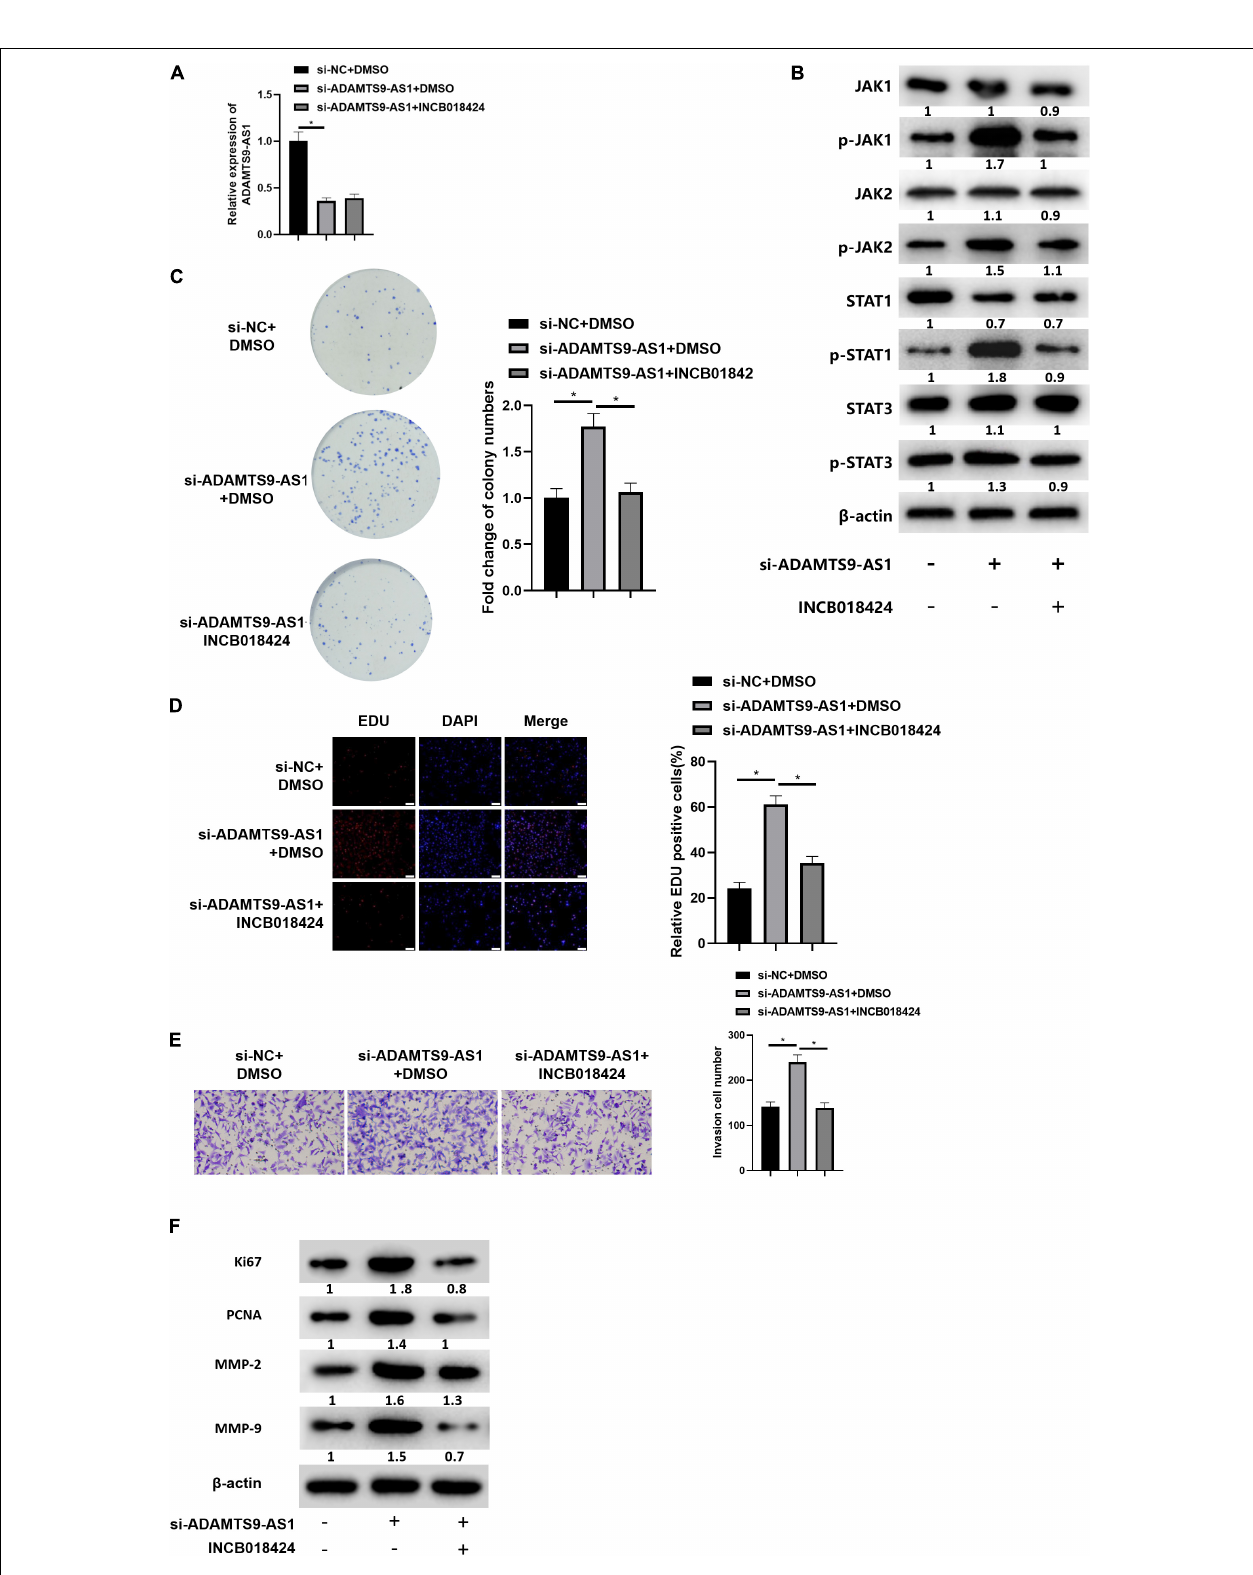
FIGURE 6 | ADAMTS9-AS1 represses cancer invasion and proliferation by regulating JAK STAT signaling pathway. (A) ADAMTS9-AS1 expression. (B) Levels of JAK STAT signaling-relevant proteins. (C) The proliferation of breast cancer cells in vitro . (D) The proliferation of breast cancer cells (400 × ). (E) Cancer cell invasion (100 × ). (F) Levels of Ki67, PCNA, MMP-2 and MMP-9. * p < 0.05.